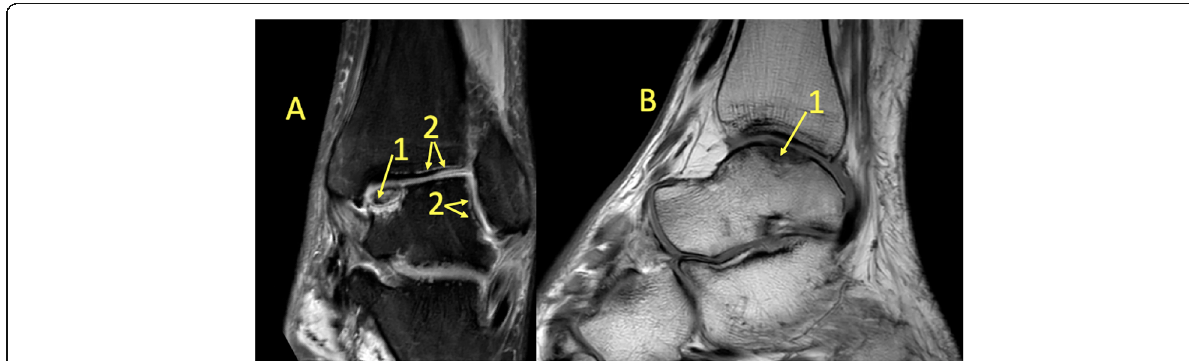
Fig. 18 A 29-year-old male with 4-month history of medial ankle pain and suspicion of an osteochondral lesion. (1) MRI showed a stable non- displaced osteochondral lesion and (2) subchondral BME, consistent with early inactive